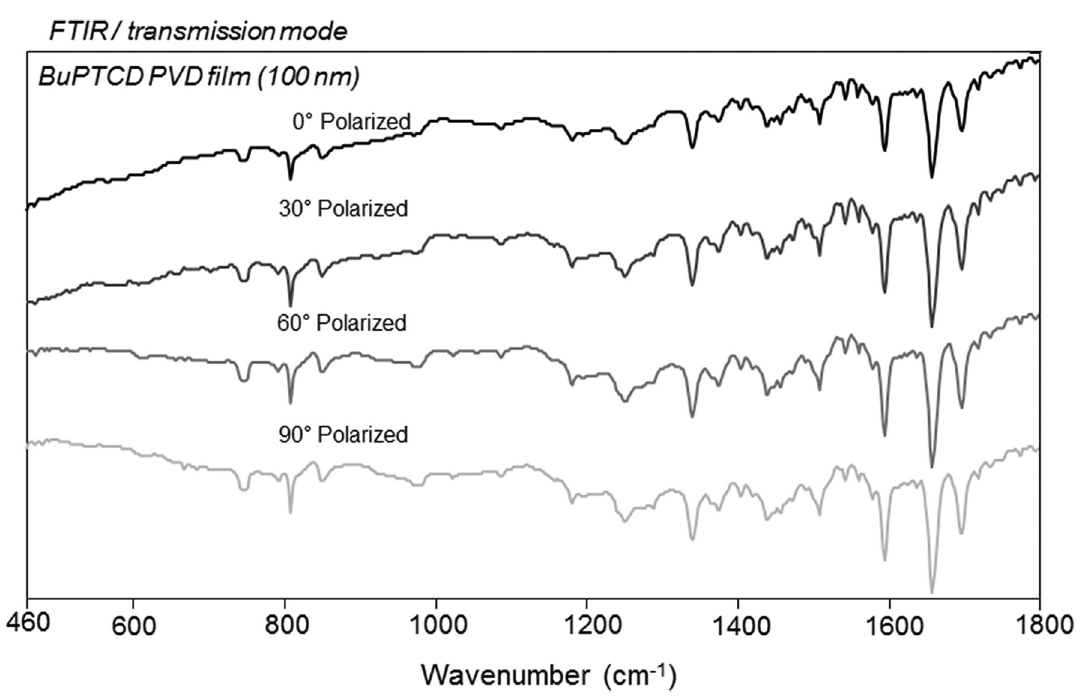
Figure 1S. Polarized FTIR spectra (transmission mode) with 0°, 30°, 60° and 90° recorded from 100 nm PVD film of BuPTCD deposited onto